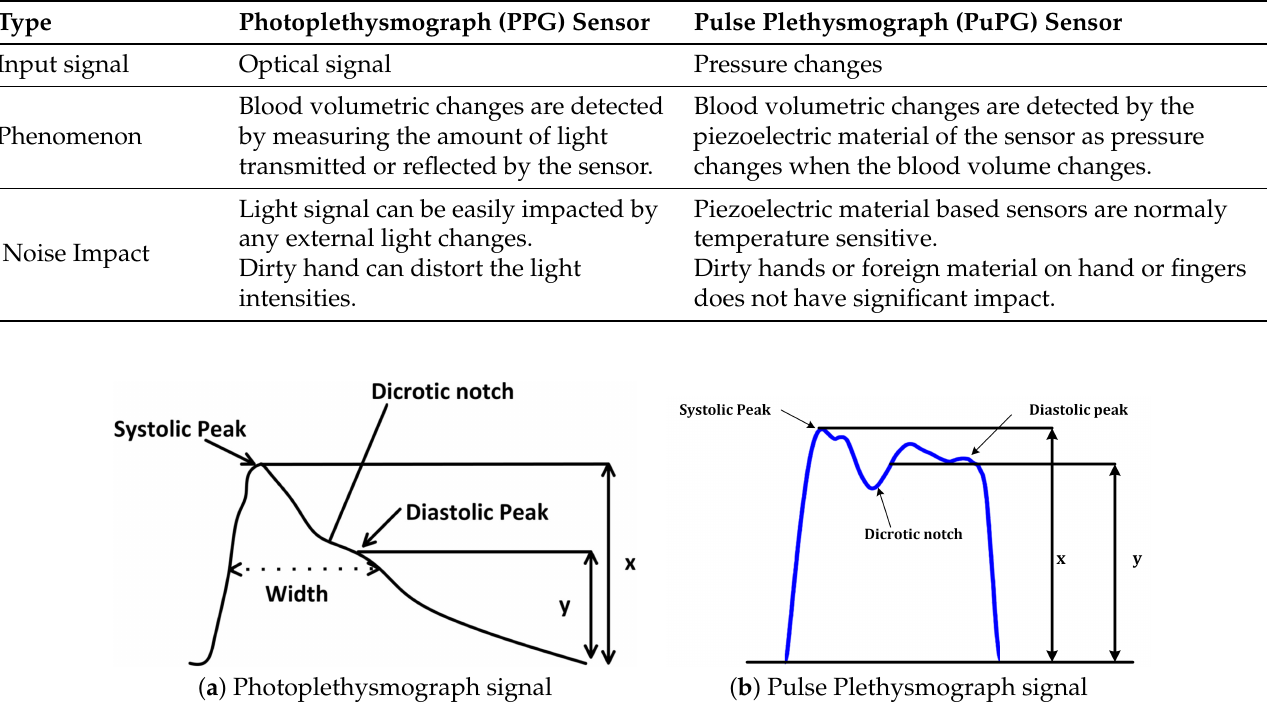
Figure 1. Visual comparison of Photoplethysmograph (PPG) and Pulse Plethysmograph (PuPG)